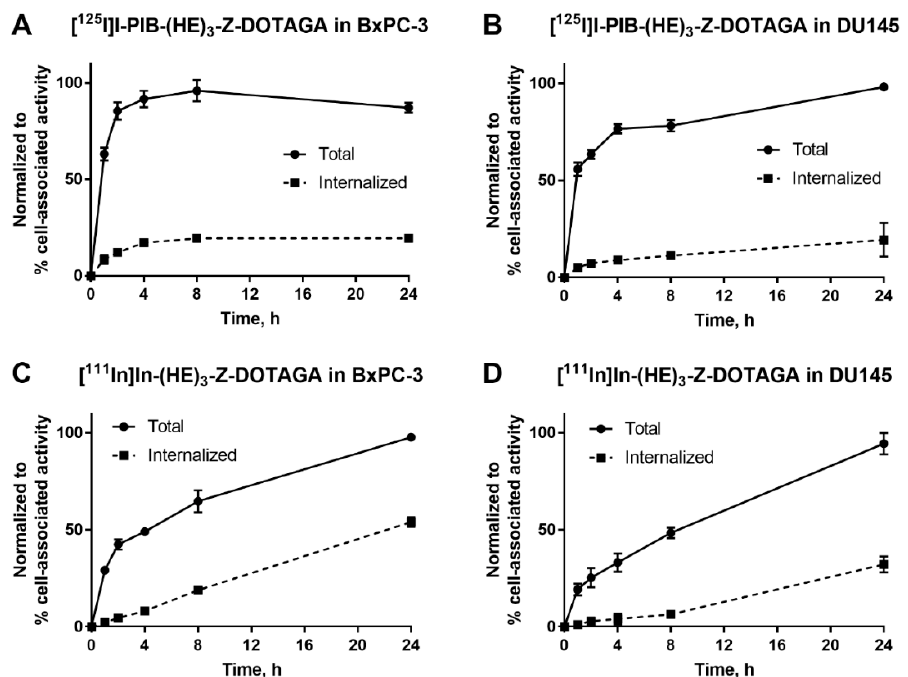
Figure 2. Cellular processing of ( A , B ) [ 125 I]I-PIB-(HE) 3 -Z HER3:08698 -DOTAGA and ( C , D ) [ 111 In]In-(HE) 3 - Z HER3:08698 -DOTAGA by HER3-expressing BxPC-3 and DU145 cells during continuous incubation over 24 h. Data are presented as mean from three samples ± SD; error bars may not be visible when they are smaller than symbols.